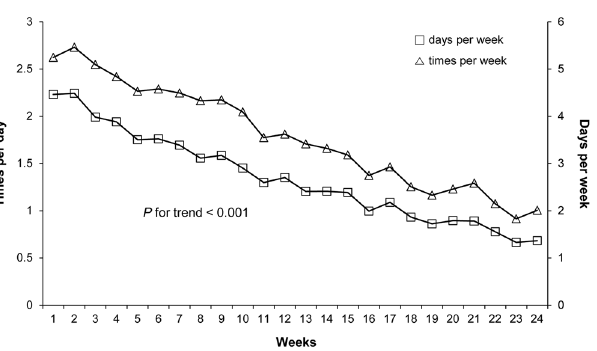
Figure 2. Frequency of weekly self-monitoring of blood glucose (SMBG) in the telemonitoring group. Data are expressed as mean ±